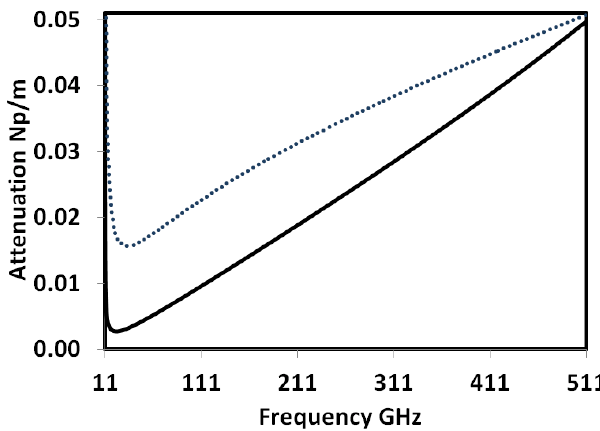
Figure 5: Attenuation of TE11 mode above cutoff but below the gap frequency in a Nb circular waveguide (with 8.1 mm radius), operating at 4.2 K (solid line) and room temperature (dotted line).